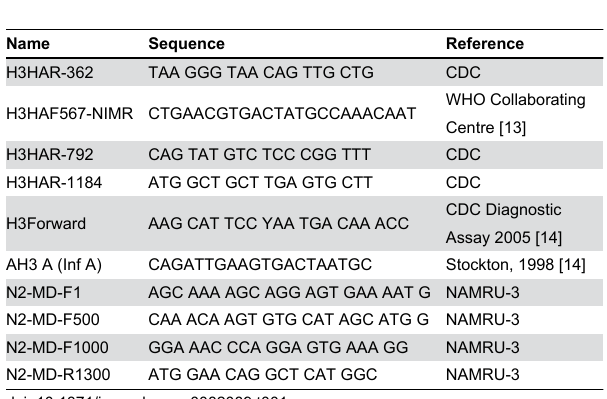
Table 1. Primers used for identification and sequencing of influenza